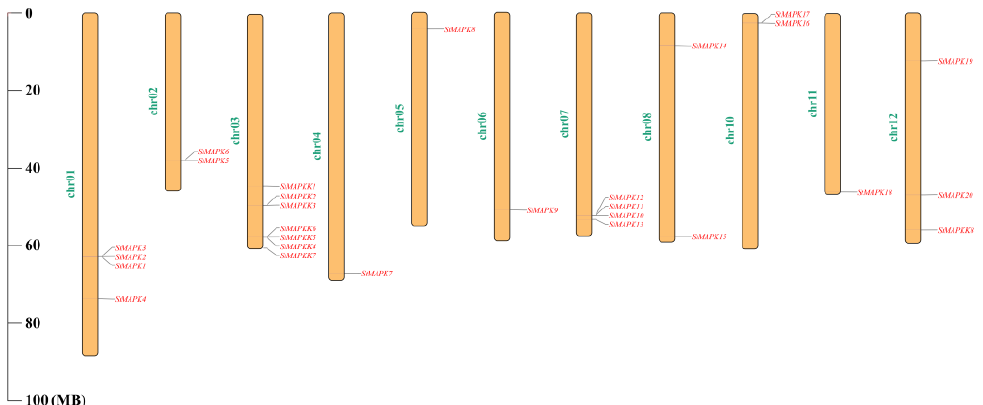
Figure 4. Chromosome location of StMAPK and StMAPKK genes.